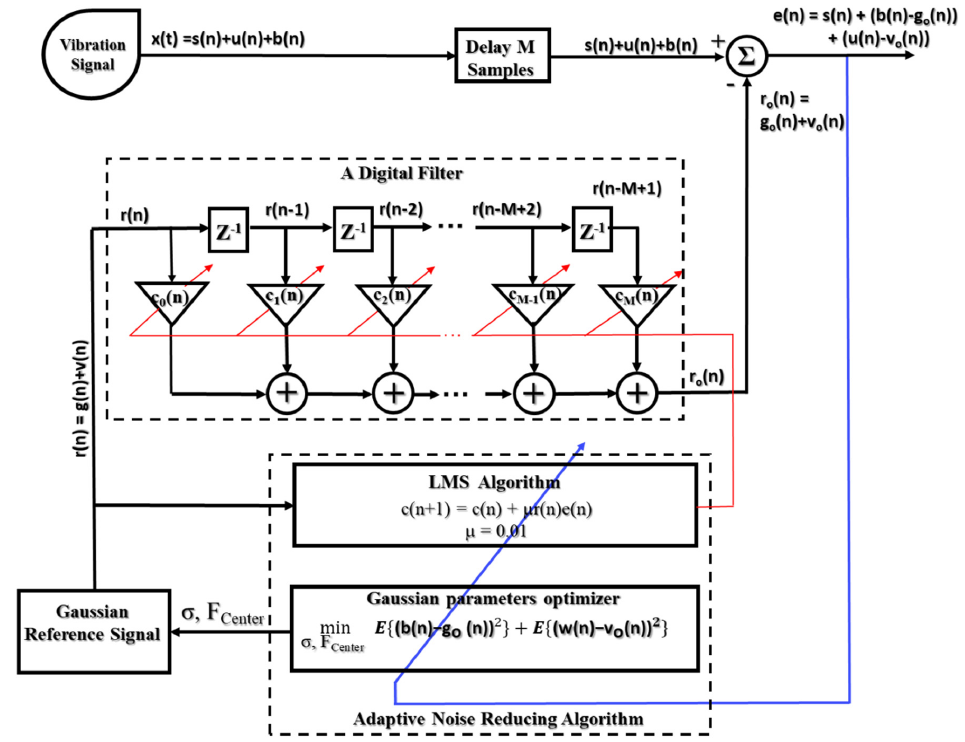
Figure 8. A function block diagram of the ANR-GRS module and parameter adjustments.